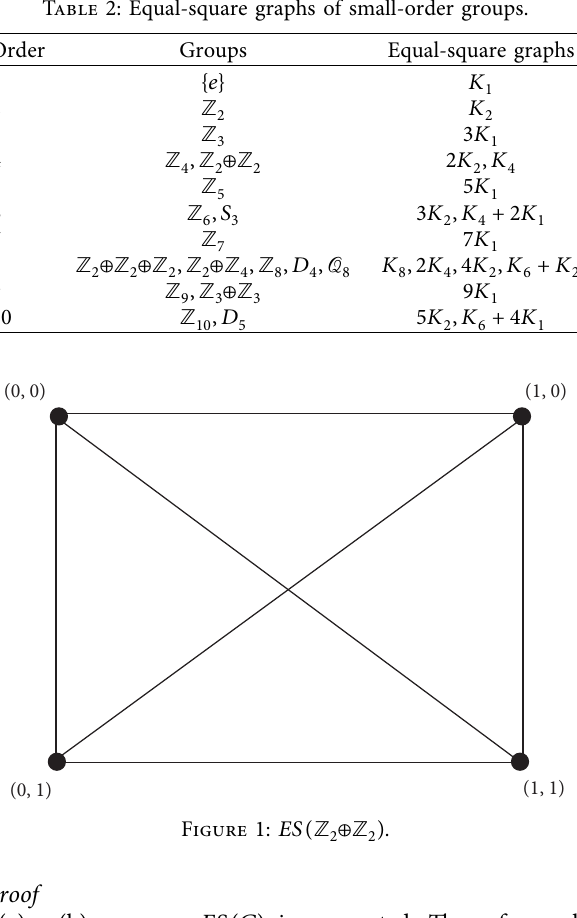
Figure 2: ES ( D ) . 6